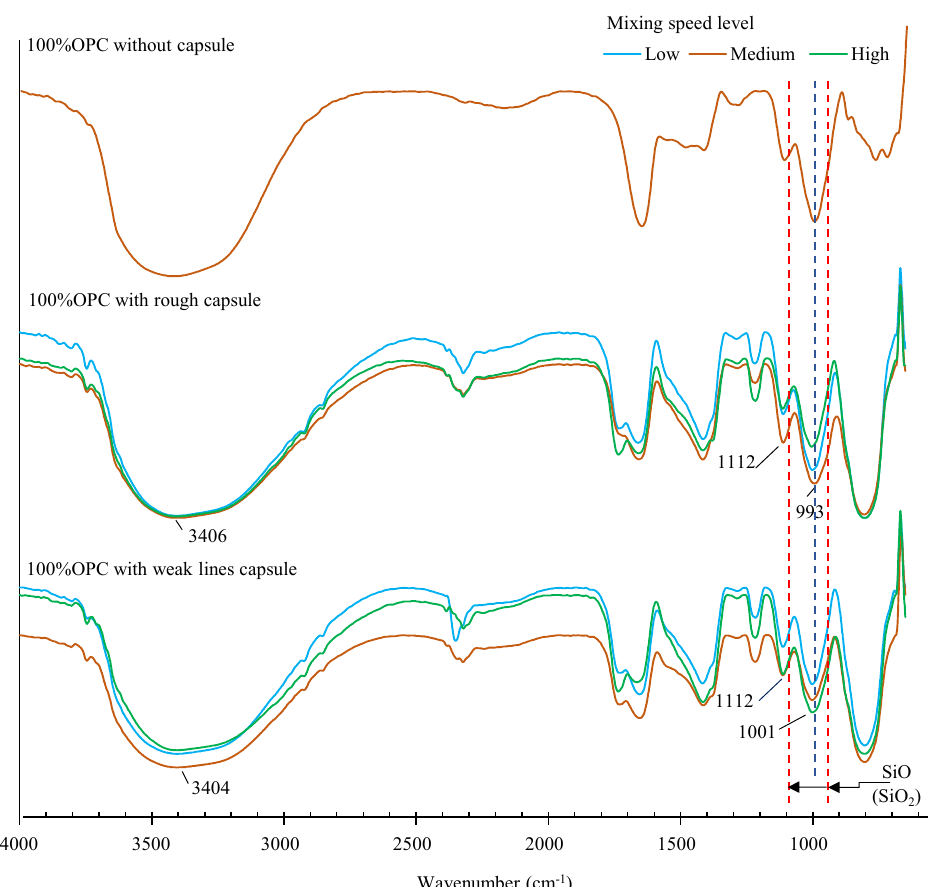
Figure 7. FTIR spectrum of 100%OPC mixes containing capsules with different types of surface texture at various rates of mixing speed.